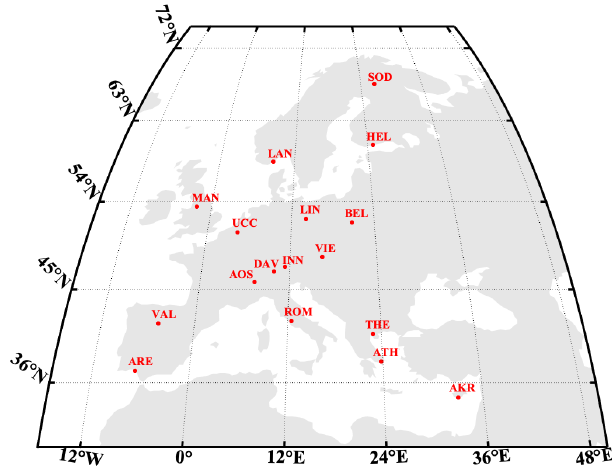
Figure 4. Study region and UVI ground measurement